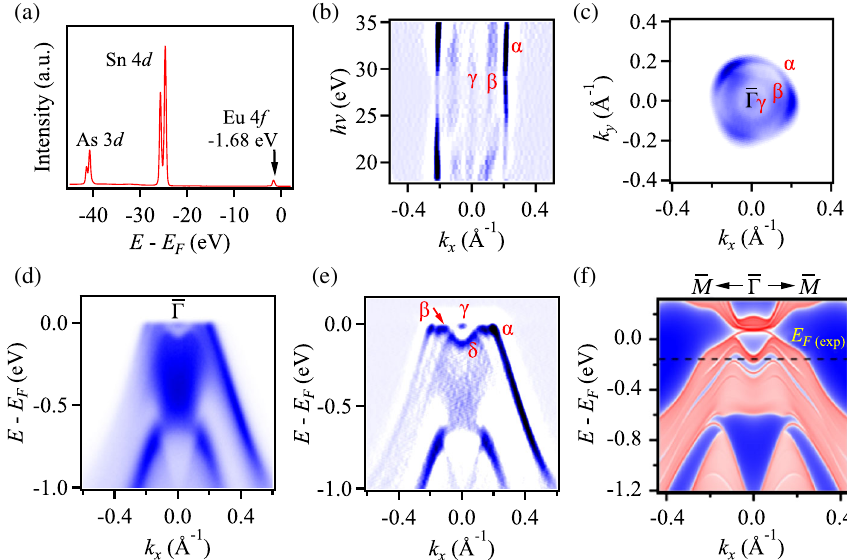
FIG. 2. Electronic structures below E F of EuSn 2 As 2 . (a) Core-level photoemission spectrum showing the characteristic peaks of As 3 d , Sn 4 d , and Eu 4 f orbitals. (b) Curvature intensity map of the ARPES data at E (c) ARPES intensity map at E F around (f) Calculated band dispersions of the (001) SSs and projected bulk states along h ν ¼ 29 eV. All ARPES data in this figure are collected at 50 K.